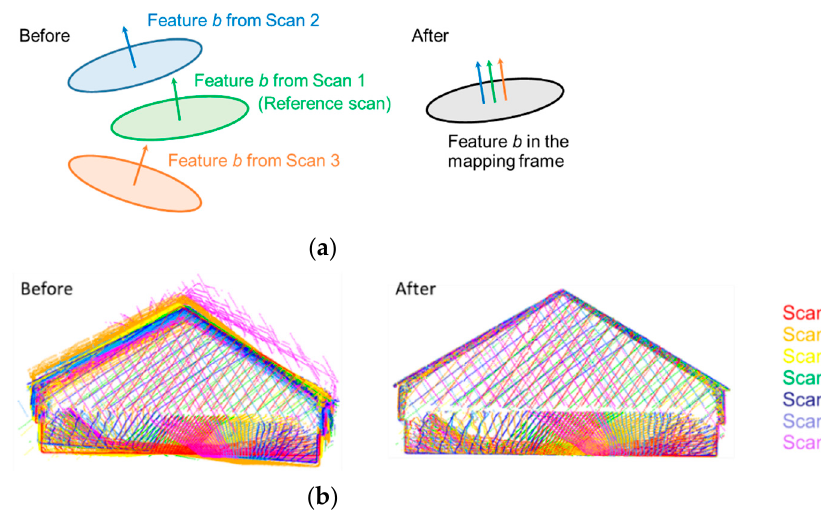
Figure 18. Illustration of feature-based fine registration: ( a ) conceptual basis of using planar features for fine registration and ( b ) sample point cloud (with seven scans) before and after registration with each scan represented by a single color.